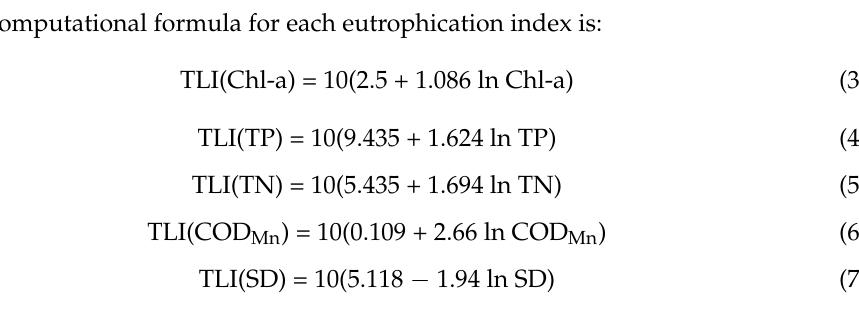
Table 2. Trophic Level Index (TLI) value ranges and corresponding trophic status for Chinese lakes. TLI TLI < 30 30 ≤ TLI ≤ 50 Oligotrophic Mesotrophic Weak–eutrophic The computational formula for each eutrophication index